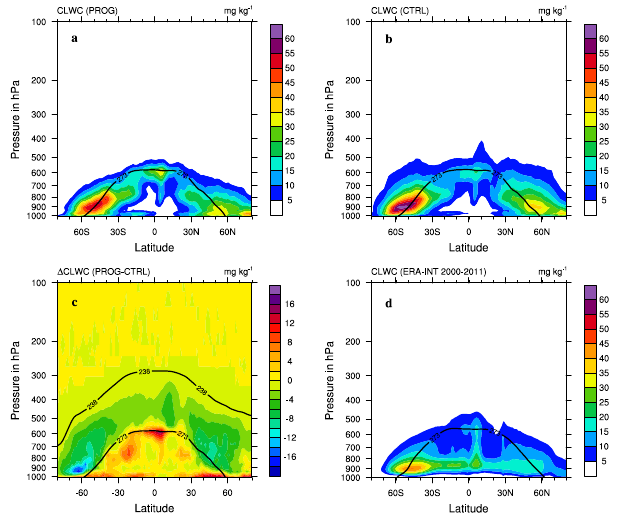
Figure 4. Annual mean liquid water content of (a) PROG, (b) CTRL, (c) the difference PROG − CTRL, and (d) ERA-interim reanalysis, where the solid black lines represent the melting and the homogeneous freezing (only in c ) levels at T = 273 and T = 238K, respectively.